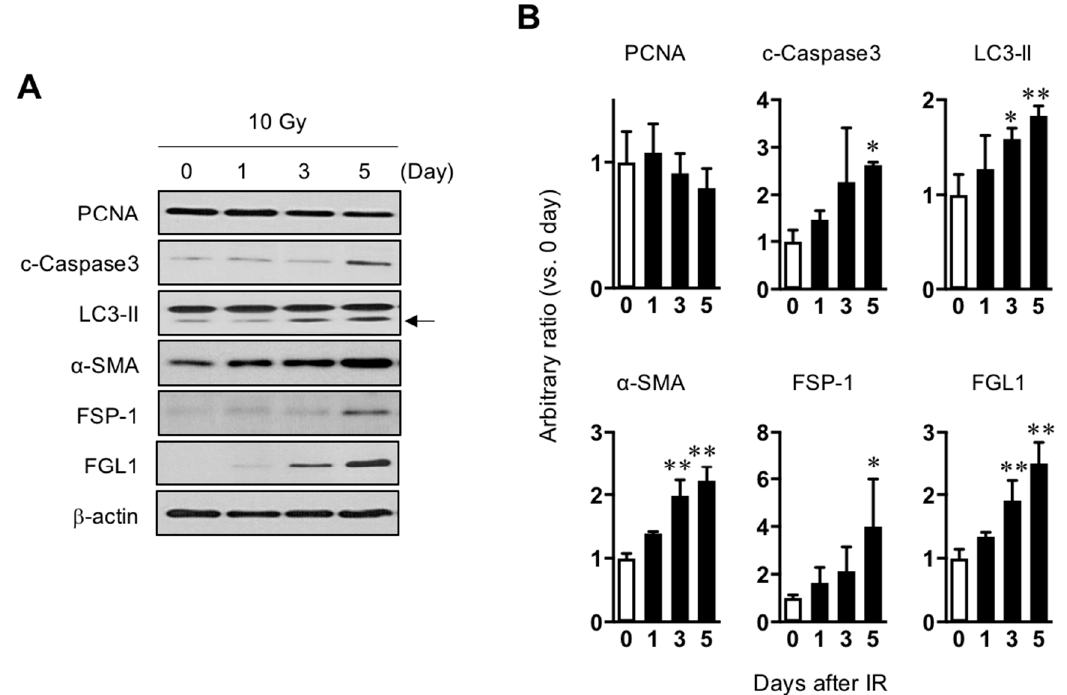
Figure 3. Association between radiation-induced hepatocyte damage and FGL1 expression. ( A ) Western blots analysis of lysates from hepatocytes treated with 10 Gy of radiation for PCNA, cleaved caspase-3, LC3-II, α -SMA, FSP-1, and FGL1 at the indicated days. ( B ) The indicated protein expression is represented as relative values compared with the non-irradiated control in the graph. Data represented Mean ± SD (n = 3, * p < 0.05 or ** p < 0.01 compared to the day 0 control).